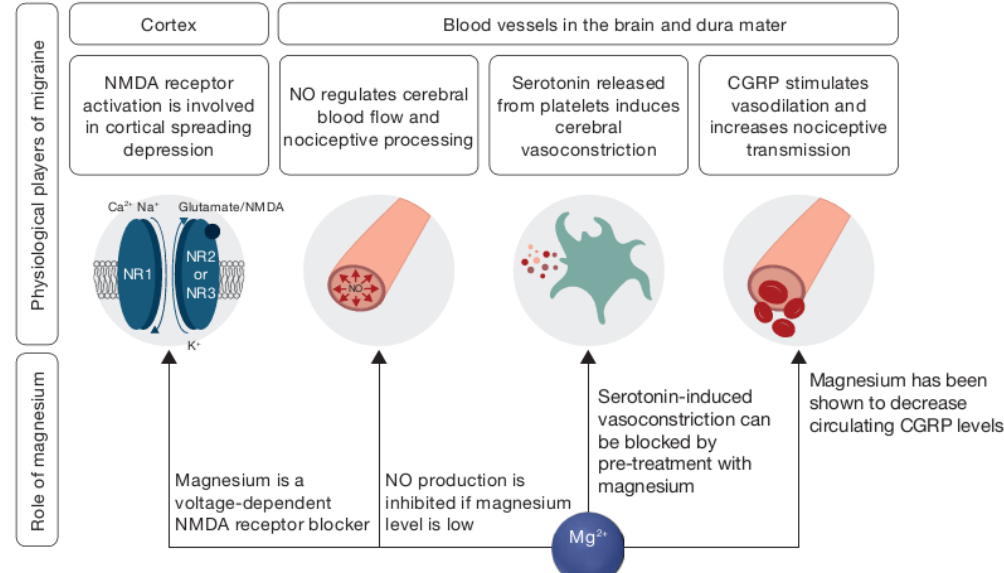
Figure 2. Mechanisms involved in migraine and possible role of magnesium. CGRP, circulating calcitonin gene-related peptide; NMDA, N-methyl-D-aspartate; NO, nitric